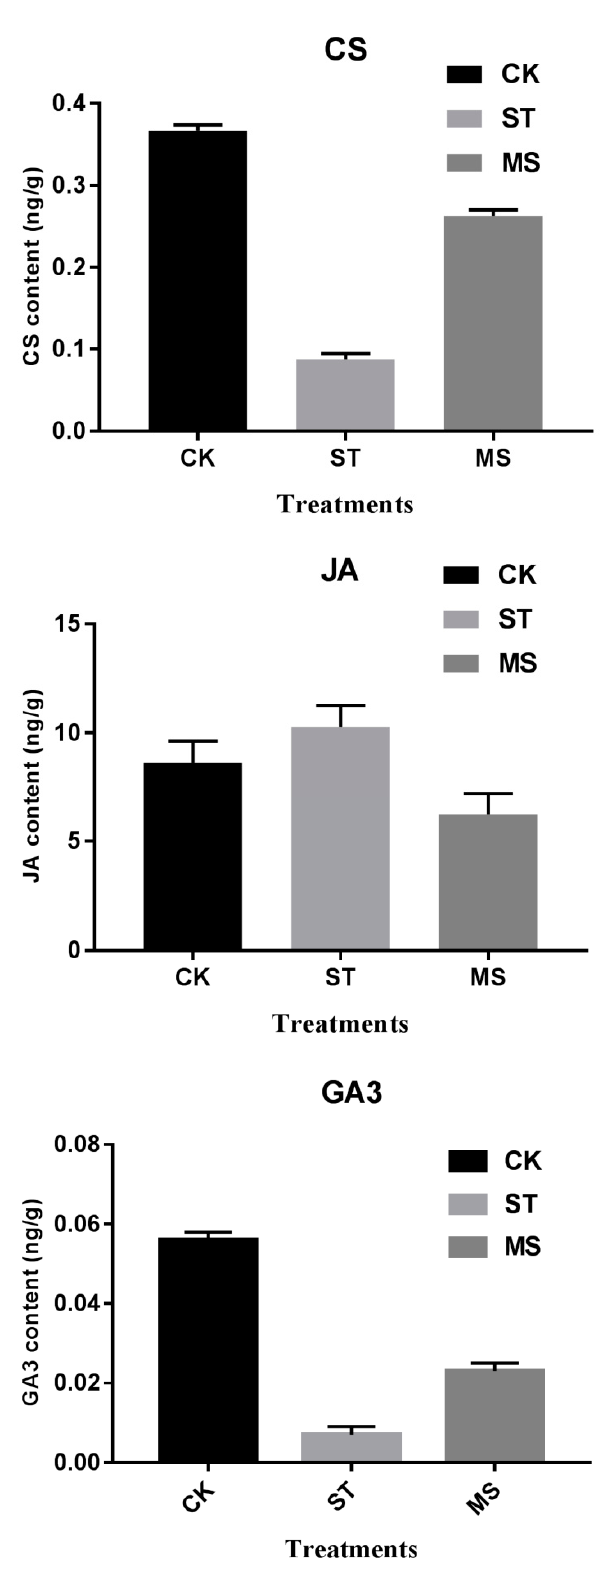
Figure 2. Contents of three hormones in seedling shoots under CK, ST, and MS treatments. CS = campesterol; JA = jasmonic acid; GA3 = gibberellic acid 3. Experiments were repeated three times, and vertical bars indicate standard errors.